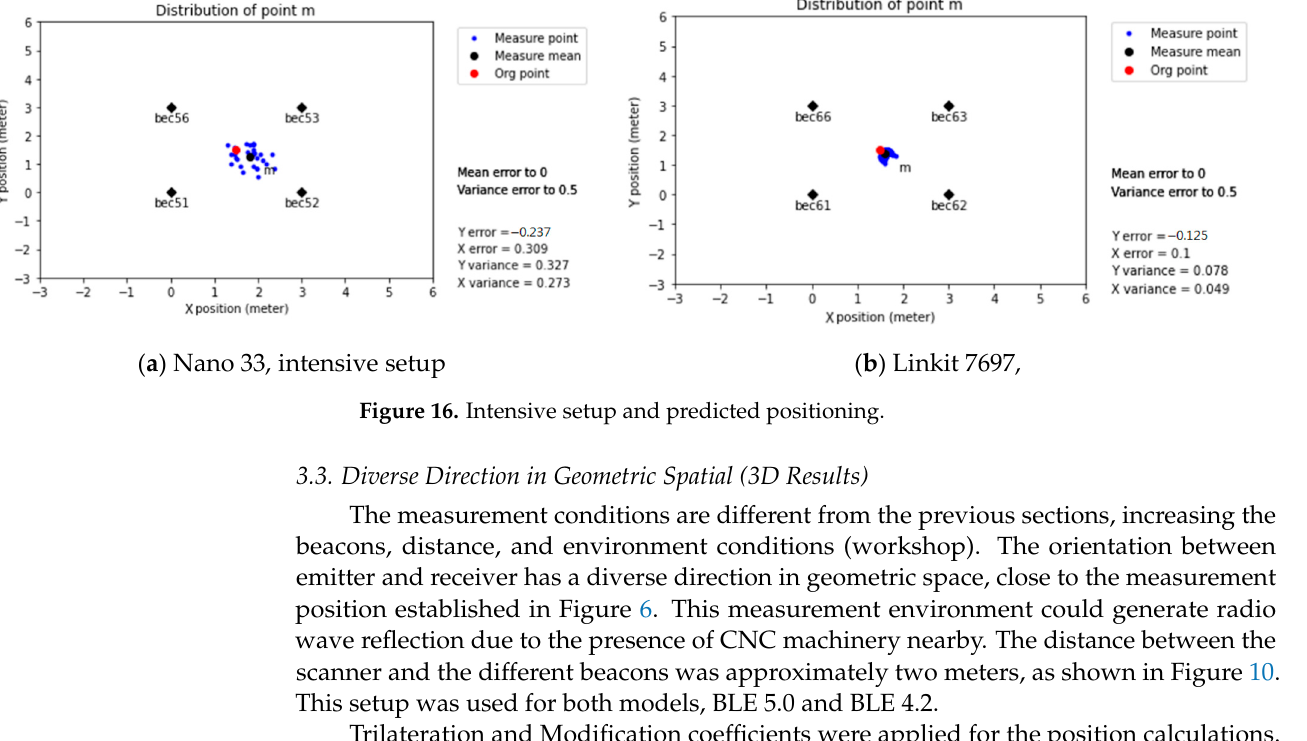
( b ) Linkit 7697, BLE 4.2 Figure 15. Common setup and predicted positioning. 3.2.3. Intensive Setup